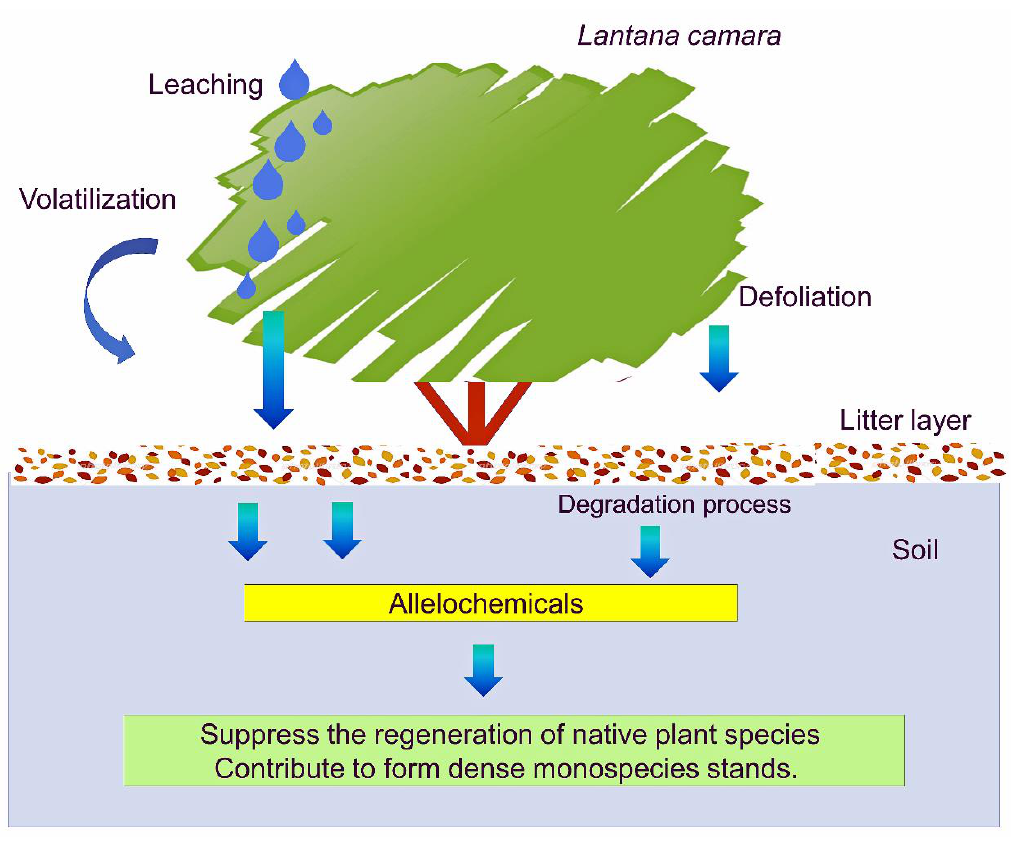
Figure 2. Allelopathy of Lantana camara contributes to forming dense monospecies stands.